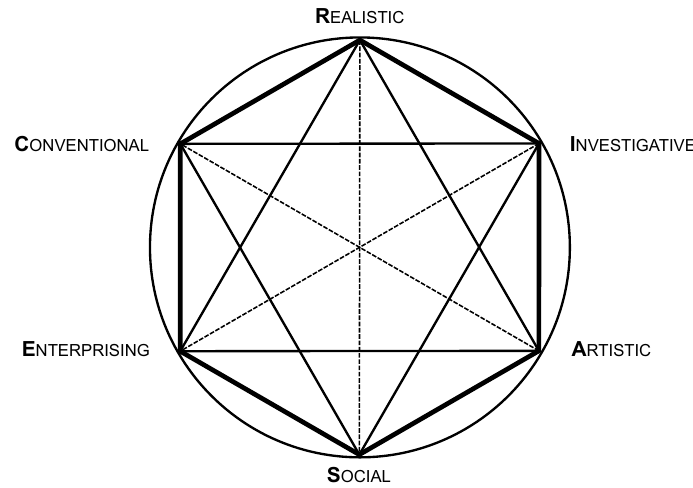
Figure 1. Hexagonal arrangement of the RIASEC